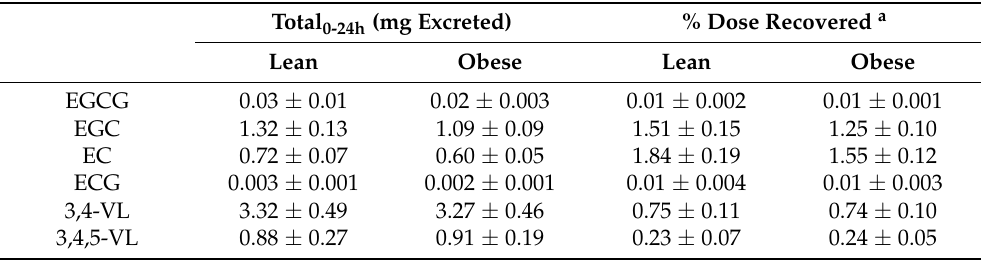
Table 4. Twenty-Four Hour urinary accumulation of parental catechins and γ -VLs. Total 0-24h (mg Excreted) % Dose Recovered a Lean Obese Lean Obese